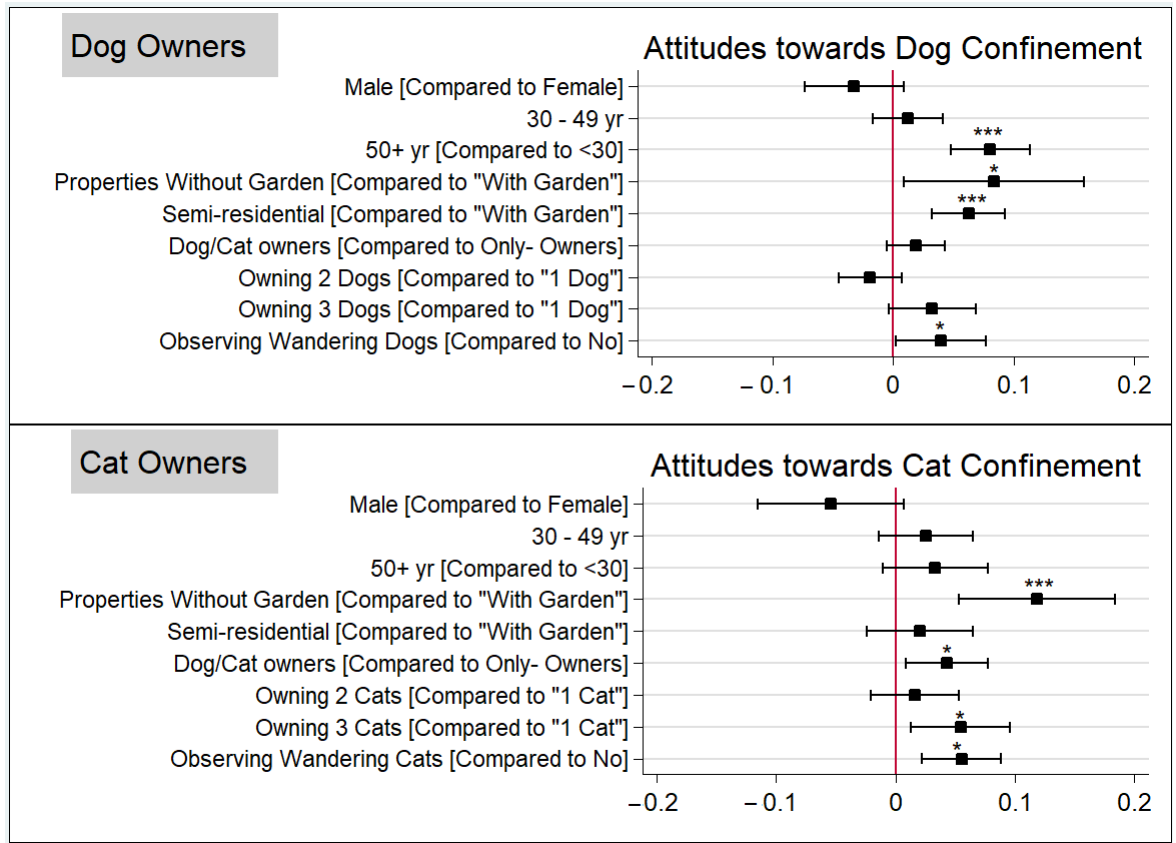
Figure 2. Associations between demographic variables and attitudes towards dog and cat confine- ment; * indicates significant differences between categories * p < 0.05, *** p > 0.001. Positive values on the x axis indicate greater support for containment and negative values indicate less support. Table 5. Prediction of supportive attitudes towards cat and dog confinement by pet owners’ concerns about wildlife and pets’ QoL, perception of others’ attitudes and pet–owner bond, separately for dogs and